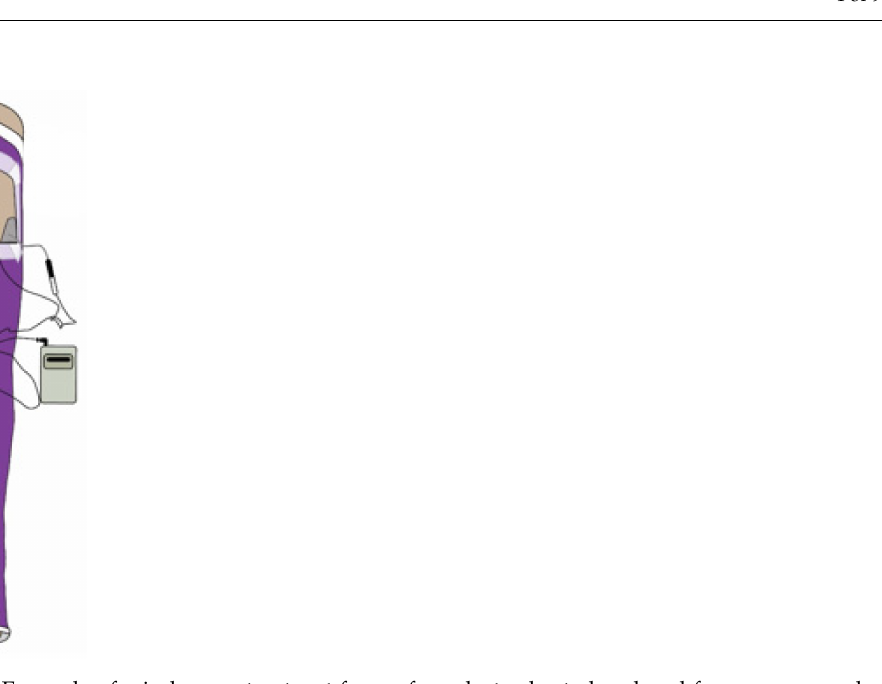
Figure 1. Example of window cast cut-out for surface electrodes to be placed for neuromuscular electrical stimulation